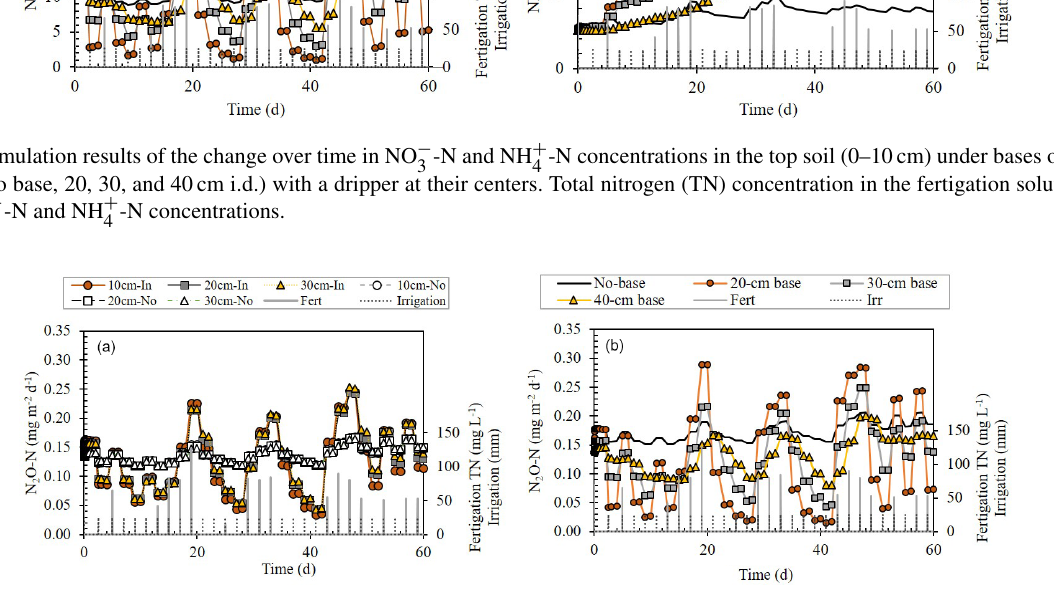
Figure 6. Simulation results of the change over time in N 2 O-N fluxes (a) at 10, 20, and 30cm below a base with a dripper at its center (In) vs. a dripper without a base (No), and (b) in the topsoil (0–10cm) under bases of variable sizes (i.e., no base, 20, 30, and 40cm i.d.) with a dripper at their centers. Total nitrogen (TN) concentration in the fertigation solution is the sum of NO −